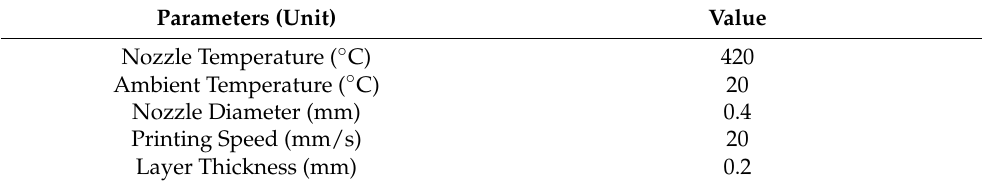
Table 2. The process parameters of 3D printing.